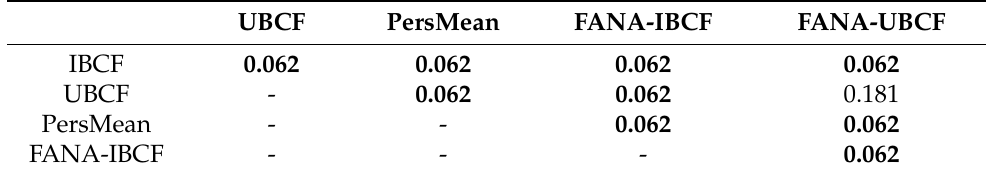
Figure 5. Box and whisker plot of RMSE with Friedman test results. Note that a p value < 0.05 means the experimental result is statistically significant. Table 6. Pairwise Wilcoxon signed-rank test of RMSE performance among IBCF, UBCF, PersMean, and our proposed approach, FANA-CF. The results in bold are statistically significant with a 90% confidence